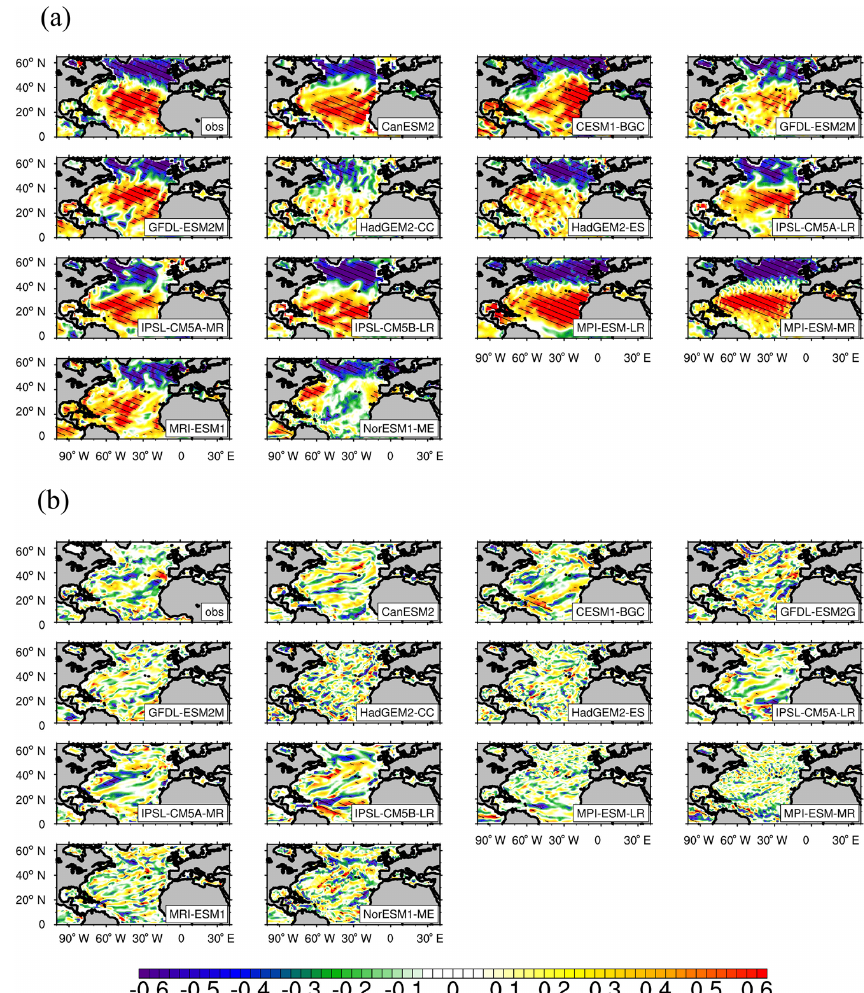
Figure 10. (a) Observed and simulated standardized RCs of the winter-average sea surface meridional velocity anomalies against the NAO index. (b) Standardized correlation coefficients between the winter-average SST anomalies and the change in SST caused by NAO-driven surface meridional velocity on an interannual scale (with 2–6-year data filtering, Eqs. 7–9). Shaded areas indicate that the correlation coef- ficients are statistically significant at the 95% confidence level of Student’s t test. The obs is the observation-based result. The time periods for the observation and models range from 1981 to 2015 and from 1955 to 2005, respectively. The simulated results are based on a historical experiment of CMIP5